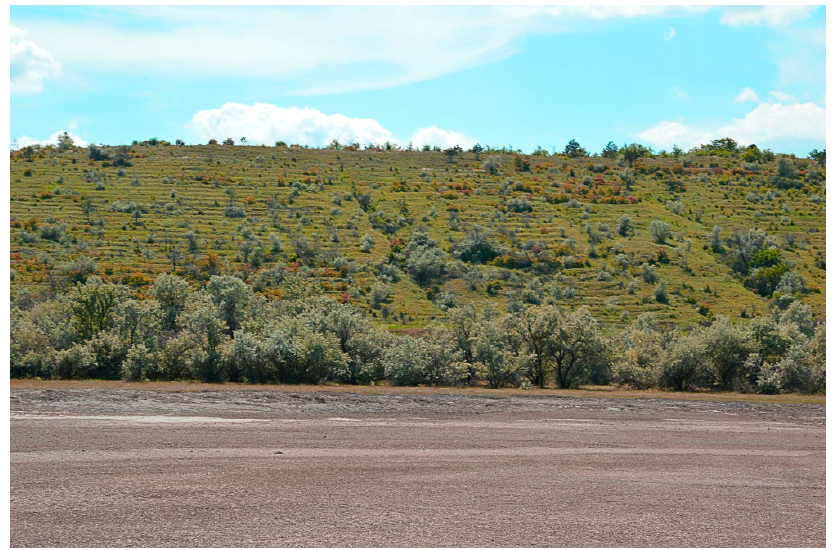
Figure 17. Artificial terraces on the left bank of the Kuyalnik Estuary valley (surroundings of Kovalivka